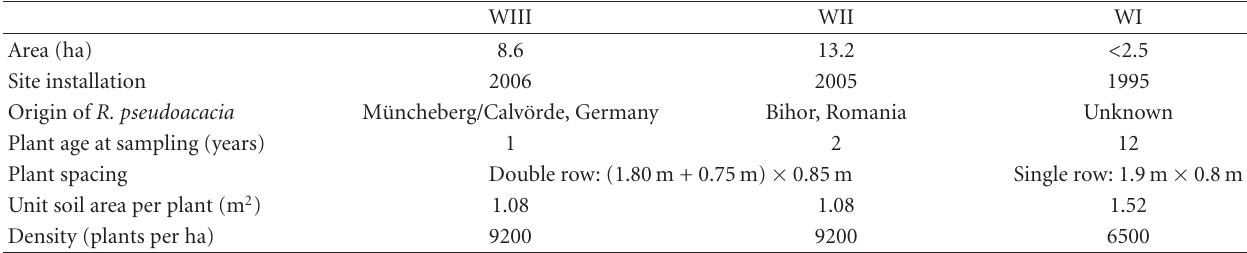
Table 1: Site descriptions of the three experimental sites with one-, two-, and twelve-year-old stands of Robinia pseudoacacia . WIII WII Area